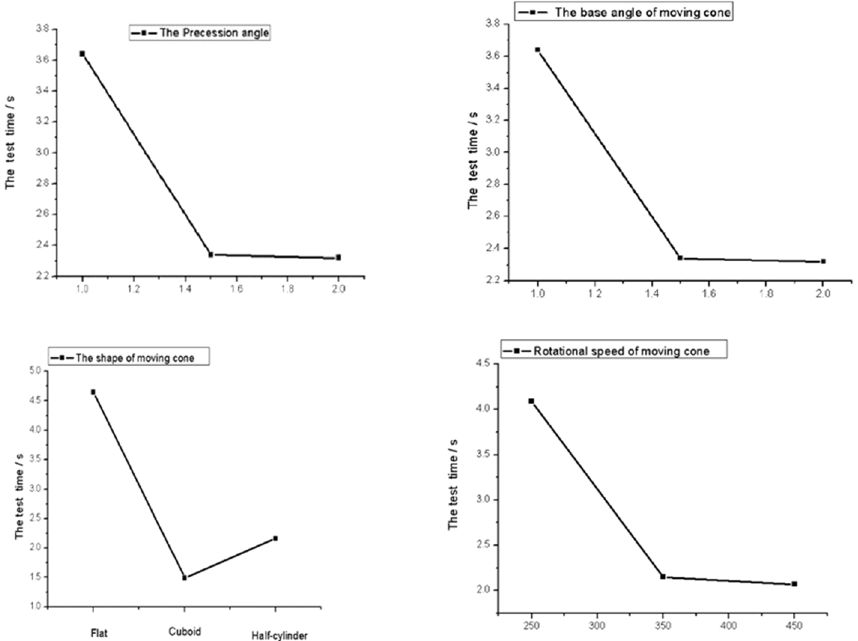
Figure 6: Line charts of crushing